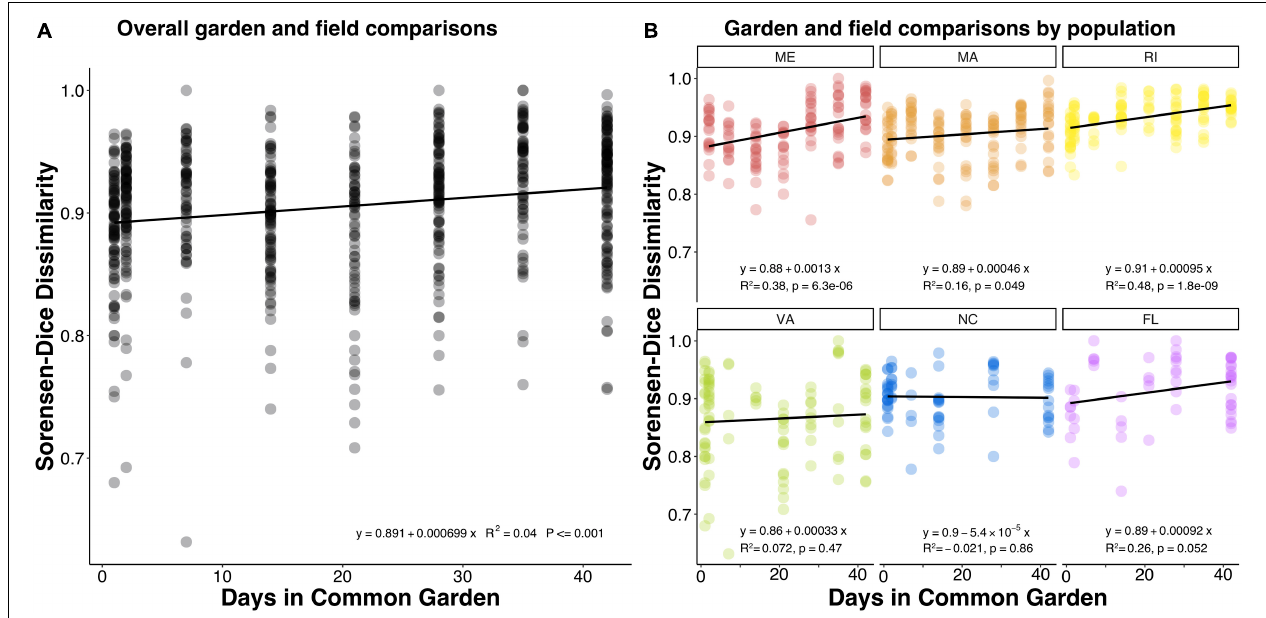
FIGURE 3 | Dot plots showing Sorensen-Dice dissimilarities comparing common garden samples to field samples within the same oyster population over the course of the experiment. Each dot represents a comparison between one common garden sample and one field sample both belonging to the same population. (A) The overall pattern for all populations, (B) the patterns of each population separately. A positive slope indicates that common garden samples became more dissimilar from their field population representatives over time.